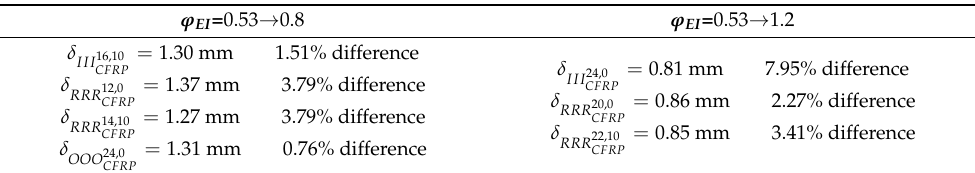
Table 5. FEA results—maximum deflections under bending loading for the proposed multi-cell beams (using rectangular envelope).